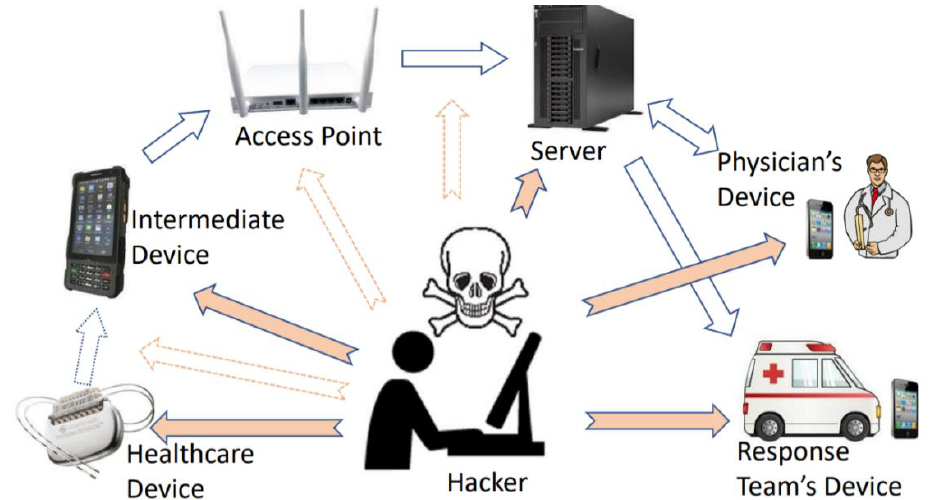
Figure 6. Possible Sites for Data Leakage in an IoHT implementation.